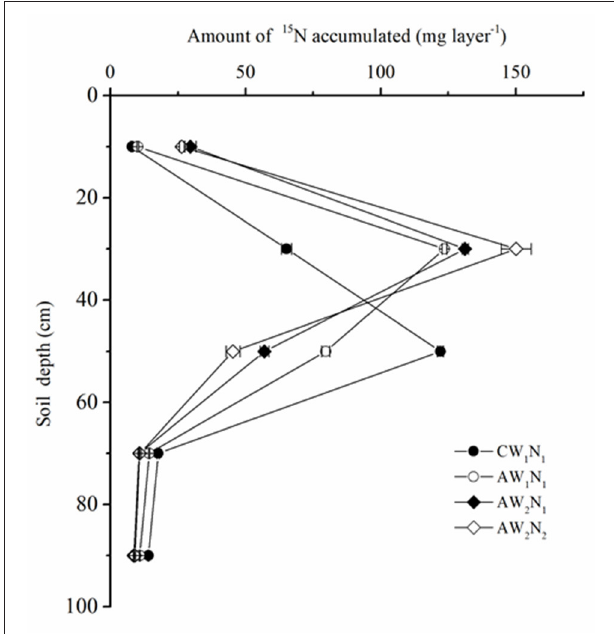
FIGURE 5 | The effects of irrigation and N supply on the distribution of labeled 15 N in different soil layers under alternate partial root-zone drip irrigation. Values are the means ± SE.